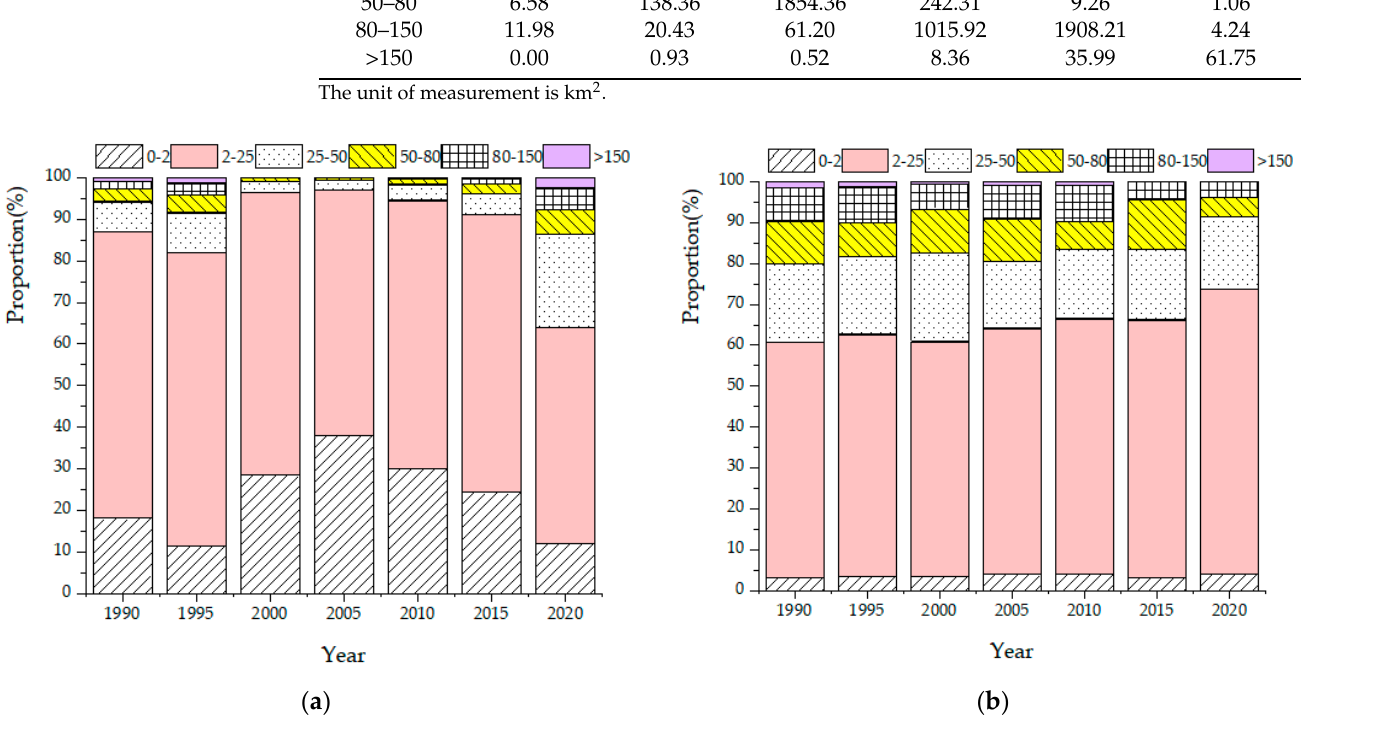
The unit of measurement is km 2 . Table 3. Soil wind erosion intensity transfer matrix in Baotou City.